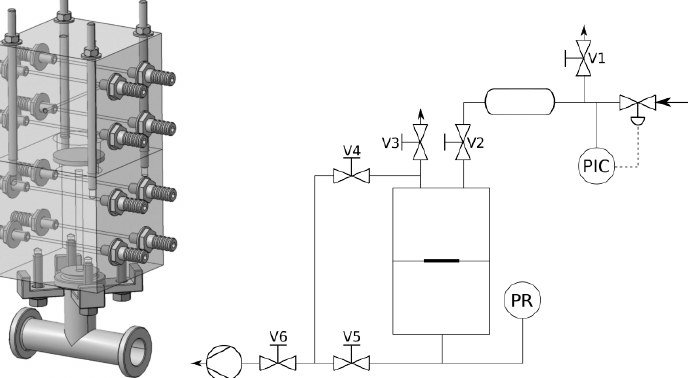
Figure 1. Manometric integral permeameter—(left) AutoCAD model of the cells and tubing, (right) technological scheme of the whole